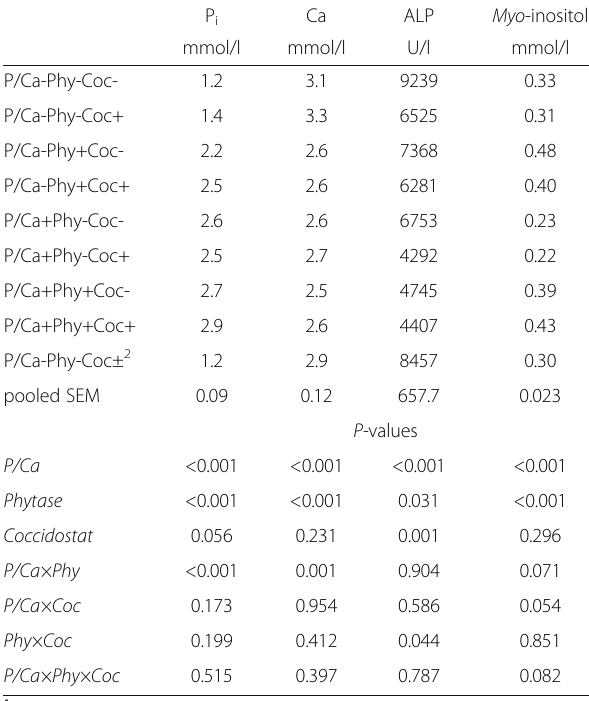
Table 3 Effect of the experimental diets on P i , Ca, ALP and myo -inositol in the blood